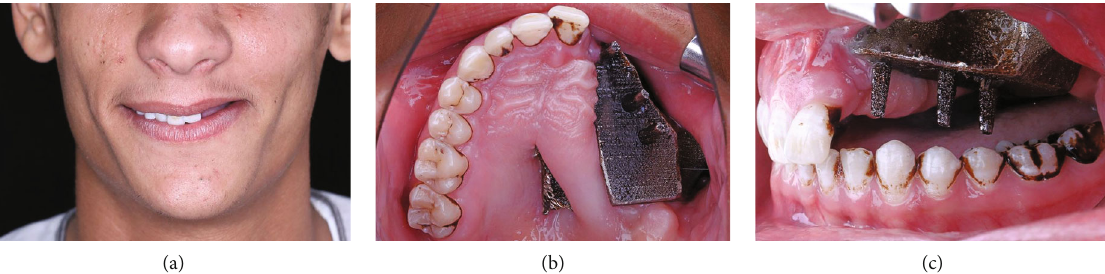
Figure 1: Initial situation when the patient presented to the prosthodontic clinic: (a) extraoral frontal view, (b) intraoral occlusal view, and (c) intraoral left side view.